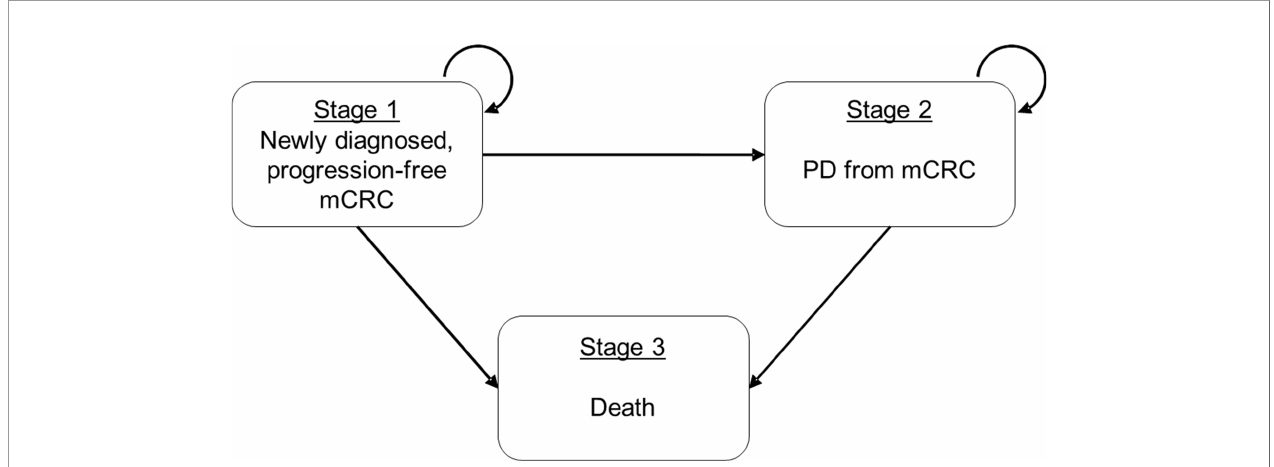
FIGURE 1 | Schematic presentation of three-state Markov model for mCRC. Simpli fi ed Schematic the three-state Markov transition model on metastatic colorectal cancer (mCRC). States 1 and 2 (mCRC and PD, respectively) are the recurrent states that patients may stay at the same state in the next time step and State 3 (Death) is the absorption state. mCRC, metastatic colorectal cancer; PD, progressive